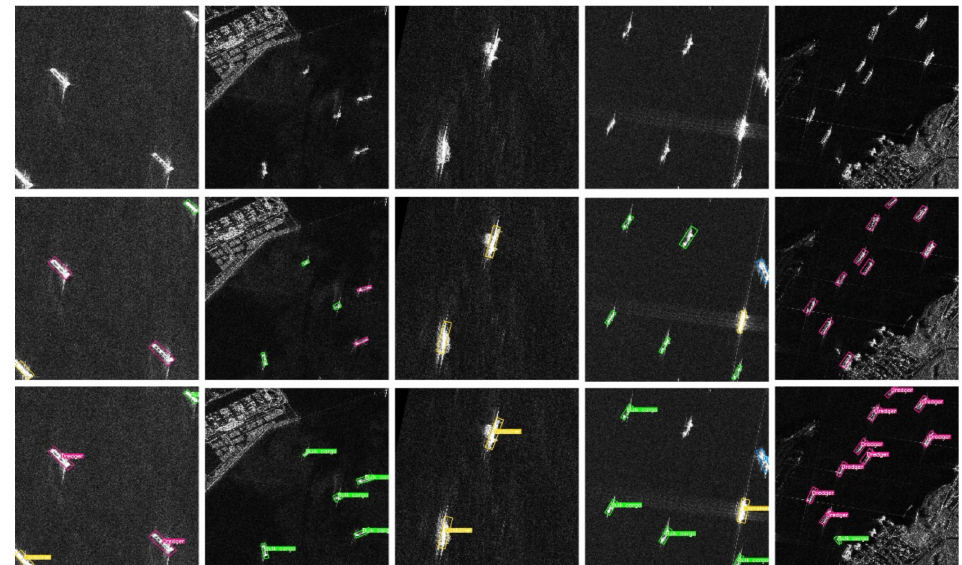
Figure 11. Detection and recognition results of offshore ships. The first column is the original SAR images, the second column is the ground truth, and the third column is our results.